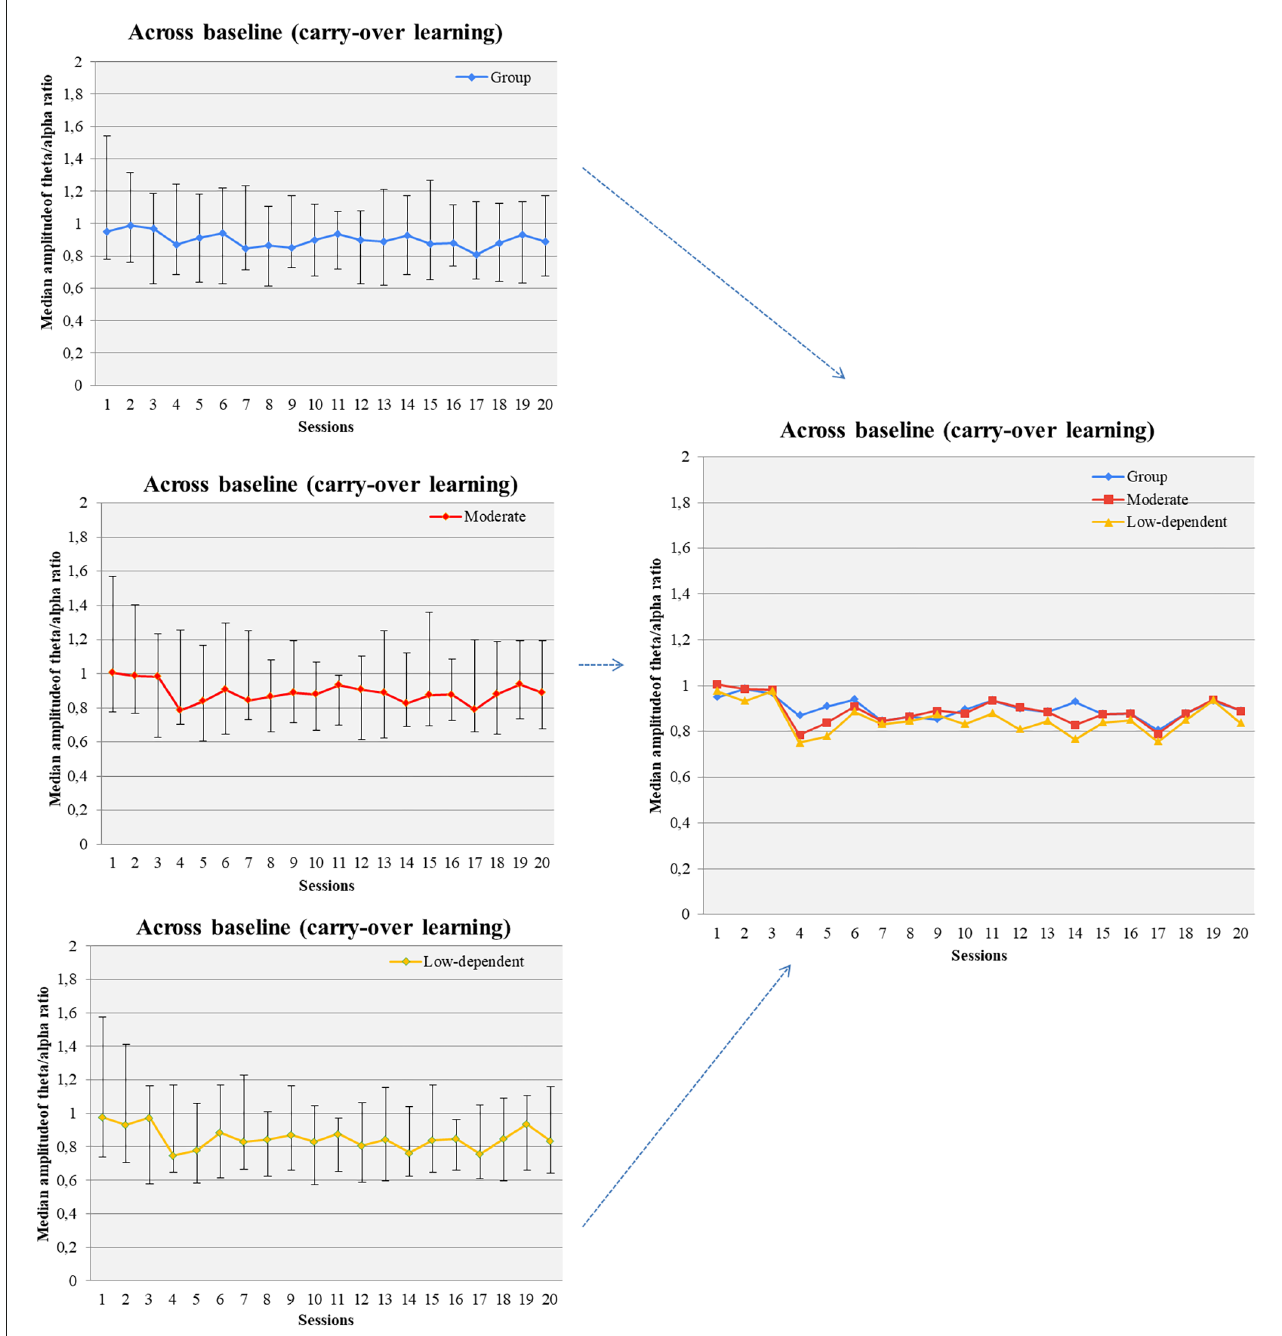
FIGURE5 Theta/alpha ratio was increased across baseline measurements of successive NF sessions (carry-over NF learning) in the pool of participants, moderate smokers, and low-nicotine dependent individuals.